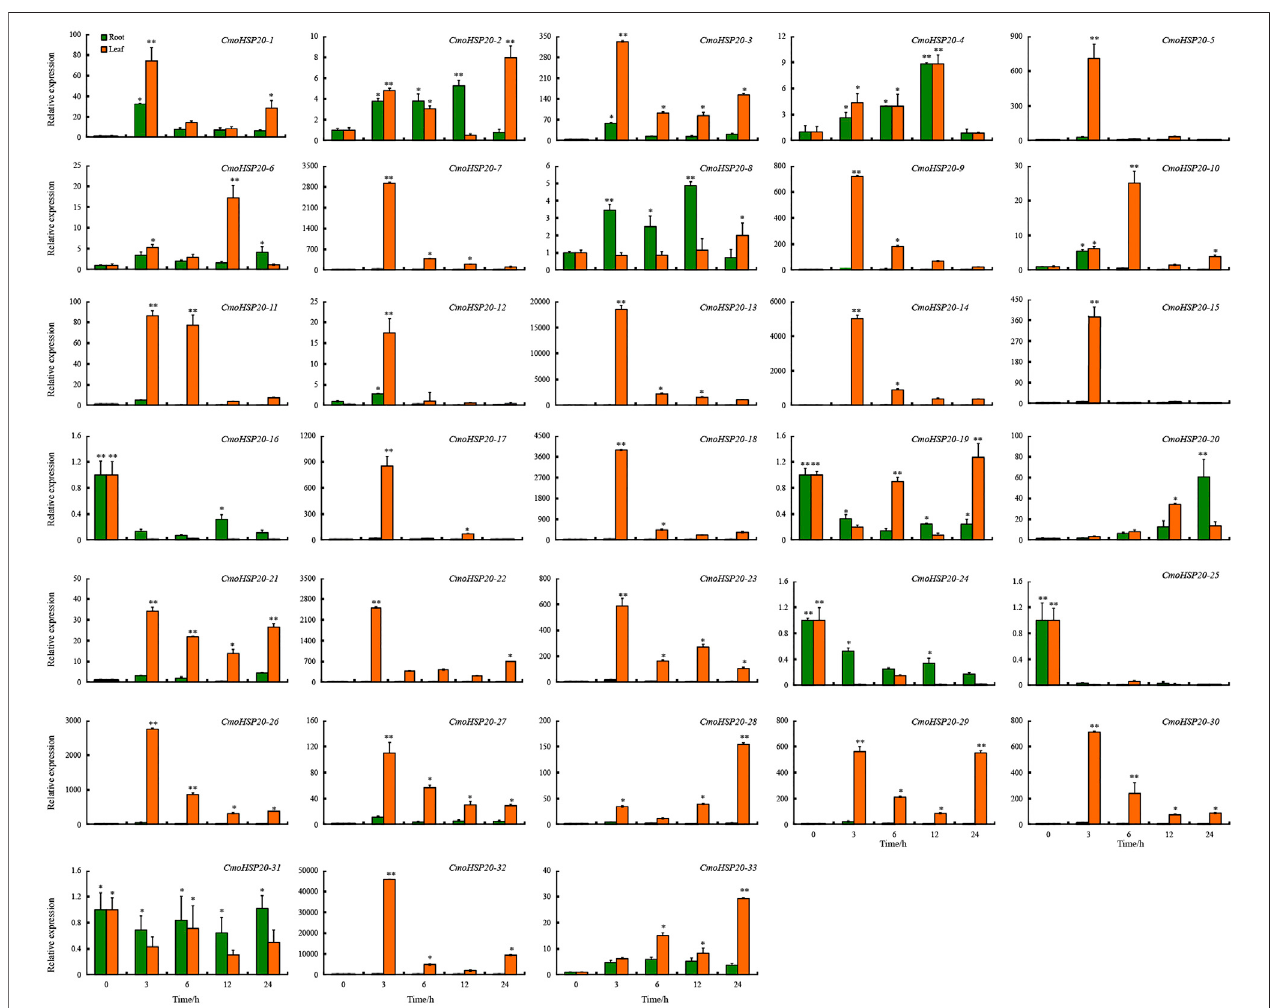
FIGURE 8 | Expression analyses of the Cucurbita moschata CmoHSP20 genes in response to heat stress using qRT-PCR. The mean expression value was calculated from three replicates. Vertical bars indicate the standard deviation. Values of 0, 3, 6, 12, and 24 indicate hours after treatment. Mean values and standard deviations are calculated according the data. Asterisk ( p or pp ) indicate a signi fi cant difference at p < 0.05 or 0.01, respectively.